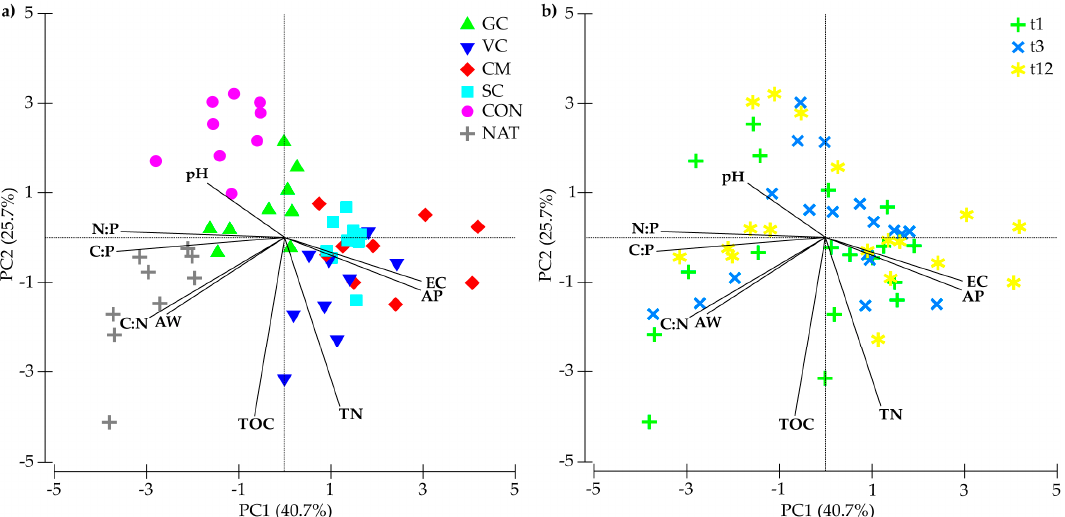
Figure 1. Principal component analysis (PCA) of soil physico-chemical properties and stoichiometry of nutrients (C, N, and P) between treatments ( a ) and between soil sampling campaign ( b )